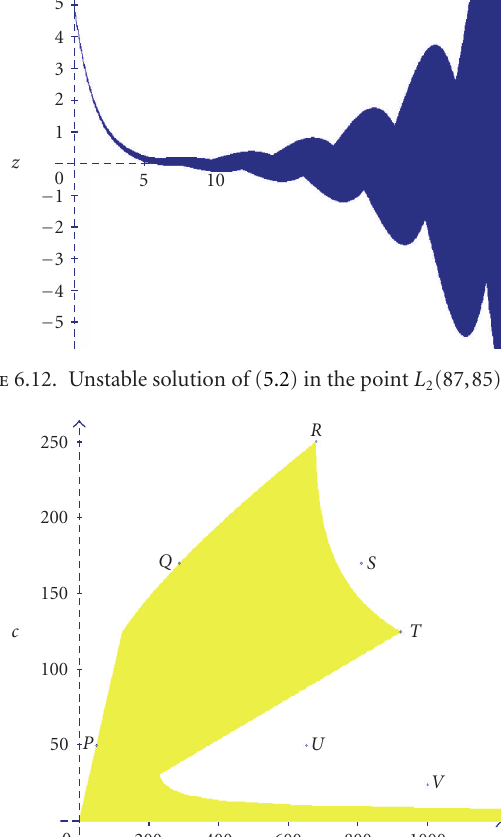
di ff erent: in the point A , it is z − 2 = 5cos(0 . 024), z − 1 = 5cos(0 . 012), z 0 = 5; in the point z A = 5cos(2 . 4), z − 2 0 , it is